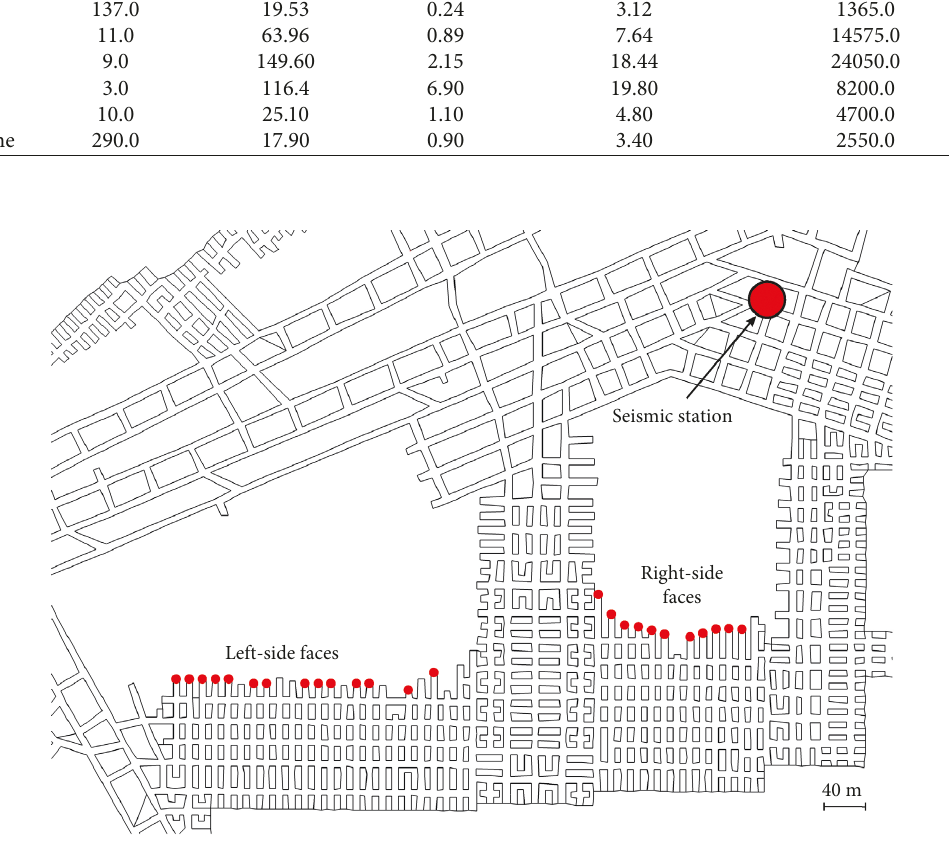
Figure 4: Selected section in Lubin mine considered in global